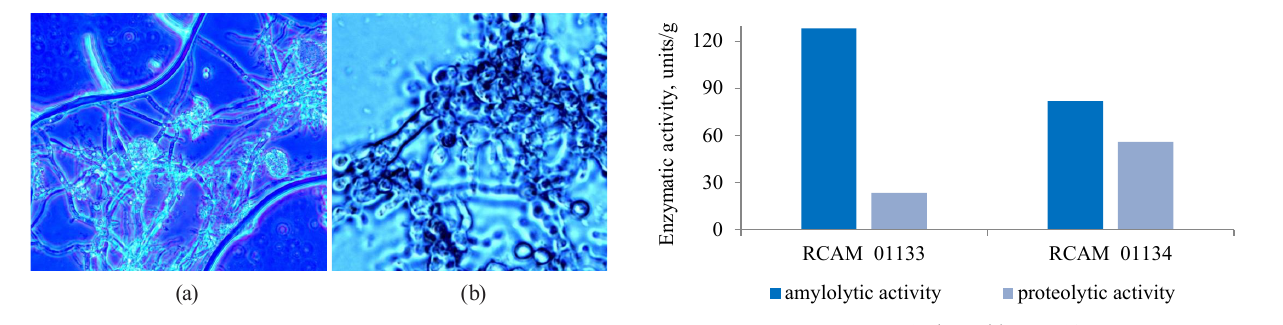
Figure 1 Aspergillus oryzae mycelium: (а) RCAM 01133; (b) RCAM 01134